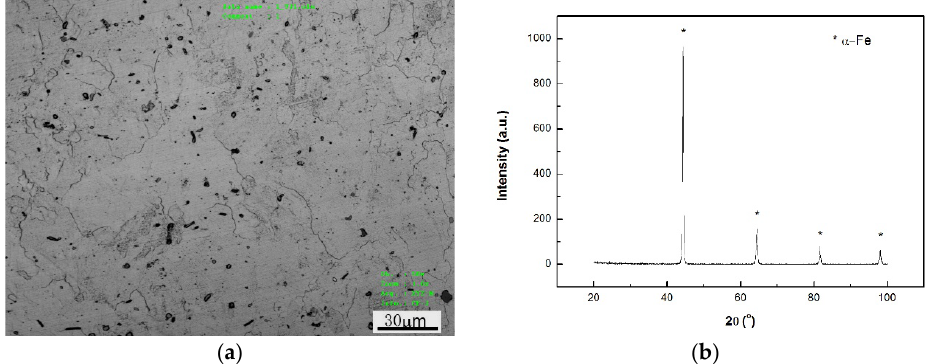
Figure 1. Optical microstructure ( a ) and X-ray diffraction (XRD) spectrum ( b ) of Fe-21.3Cr-3.5Al-0.5Ti-0.4Zr steel.